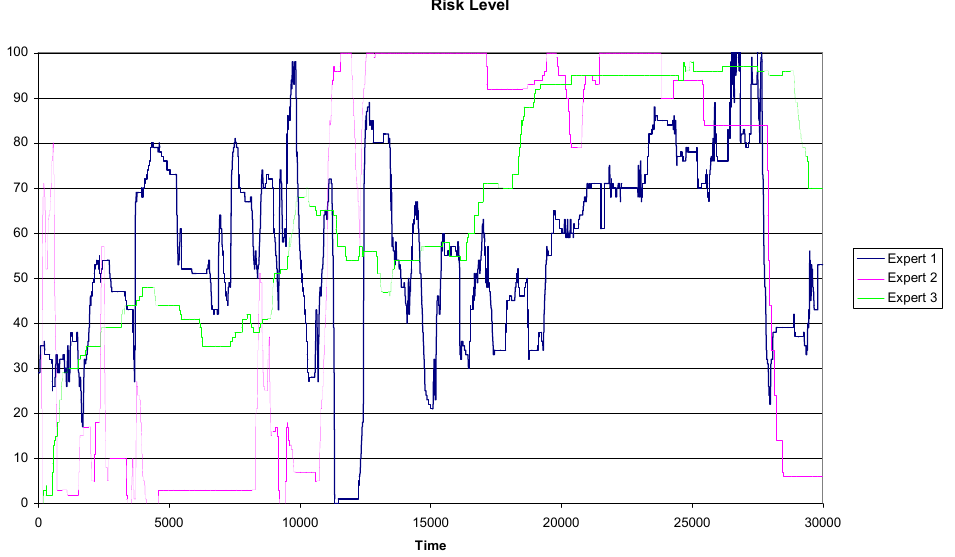
Figure 4. Quantitative evaluation of the risk by the